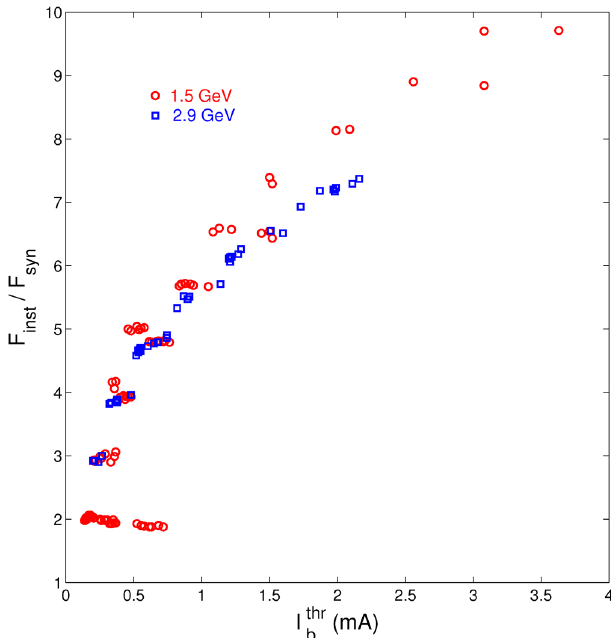
FIG. 4. Instability frequency normalized by the true synchro- tron frequency as a function of the threshold bunch current at 1.5 and 2.9 GeV. A tight clustering around the lower integers is